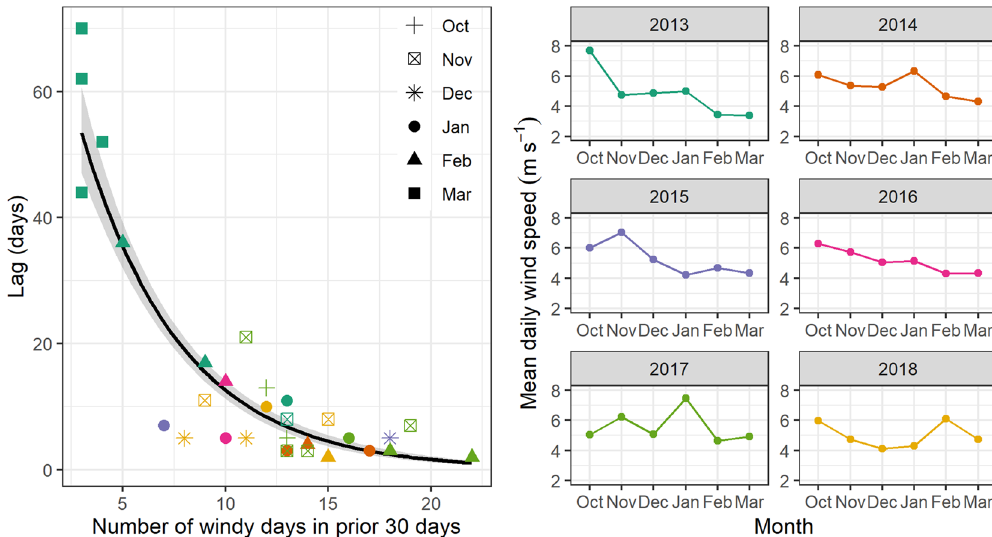
Figure 4. Left panel: the lag between wind events and blue whale aggregations vs. the number of days with wind speed above 5.5 m s −1 in the preceding 30 days to the aggregation. Each point represents a blue whale aggregation, symbolized by month and colored by year. The black line represents the fitted relationship using a generalized linear model with a Poisson distribution. Right panels: mean daily wind speed recorded at the Farewell Spit weather station for each month in the spring–summer. The labeled year of each plot represents the year during